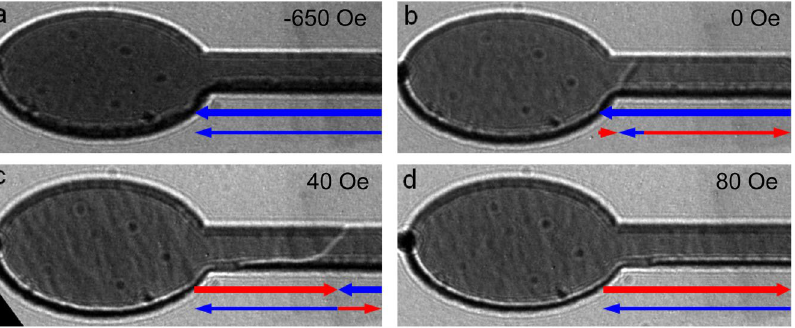
Figure 2. LTEM images of SyF nanowire with 800 nm wide track. The sequence of images shows the reversal of the ellipse and nucleation of a 180° AFM DW. The layers are t 1 = 13.3 nm and t 2 = 6.6 nm thick separated by a 0.7 nm thick Ru spacer layer. The transmission images contain contrast that arises as a projection of both layers. The images are taken for applied in-plane horizontal fields of ( a ), − 650 Oe, saturation state, ( b ) 0 Oe, ellipse reversed and 360° wall formed in the thinner Co 90 Fe 10 layer, ( c ) 40 Oe, 180° AFM DW formed, and ( d ) 80 Oe, AFM DW removed. The red and blue arrows indicate the inferred direction of the magnetisation in each layer, with the thick/thin arrows representing the thicker (top) and thinner (bottom) layer